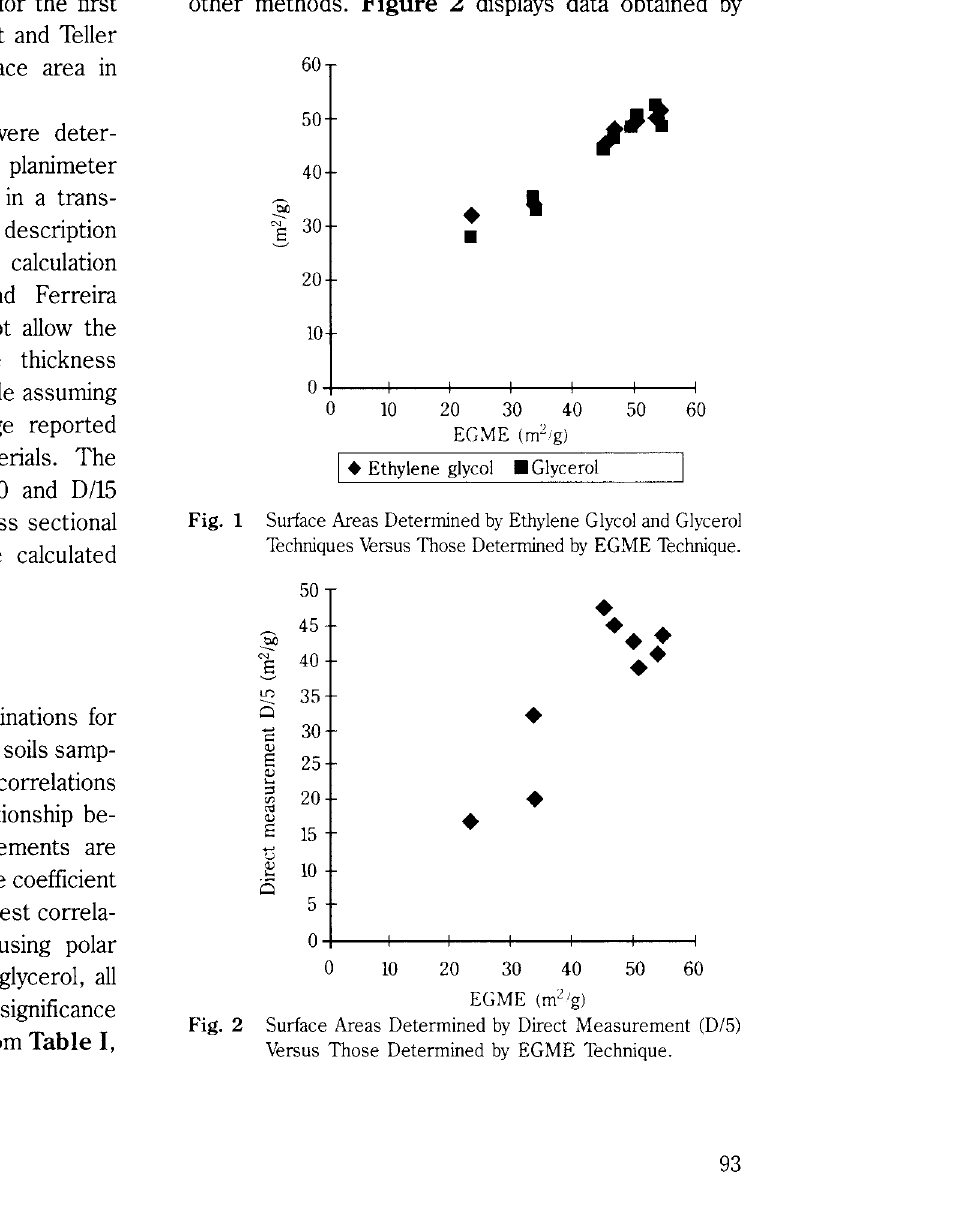
Fig. 2 Surface Areas Determined by Direct Measurement (D/5) Versus Those Determined by EGME